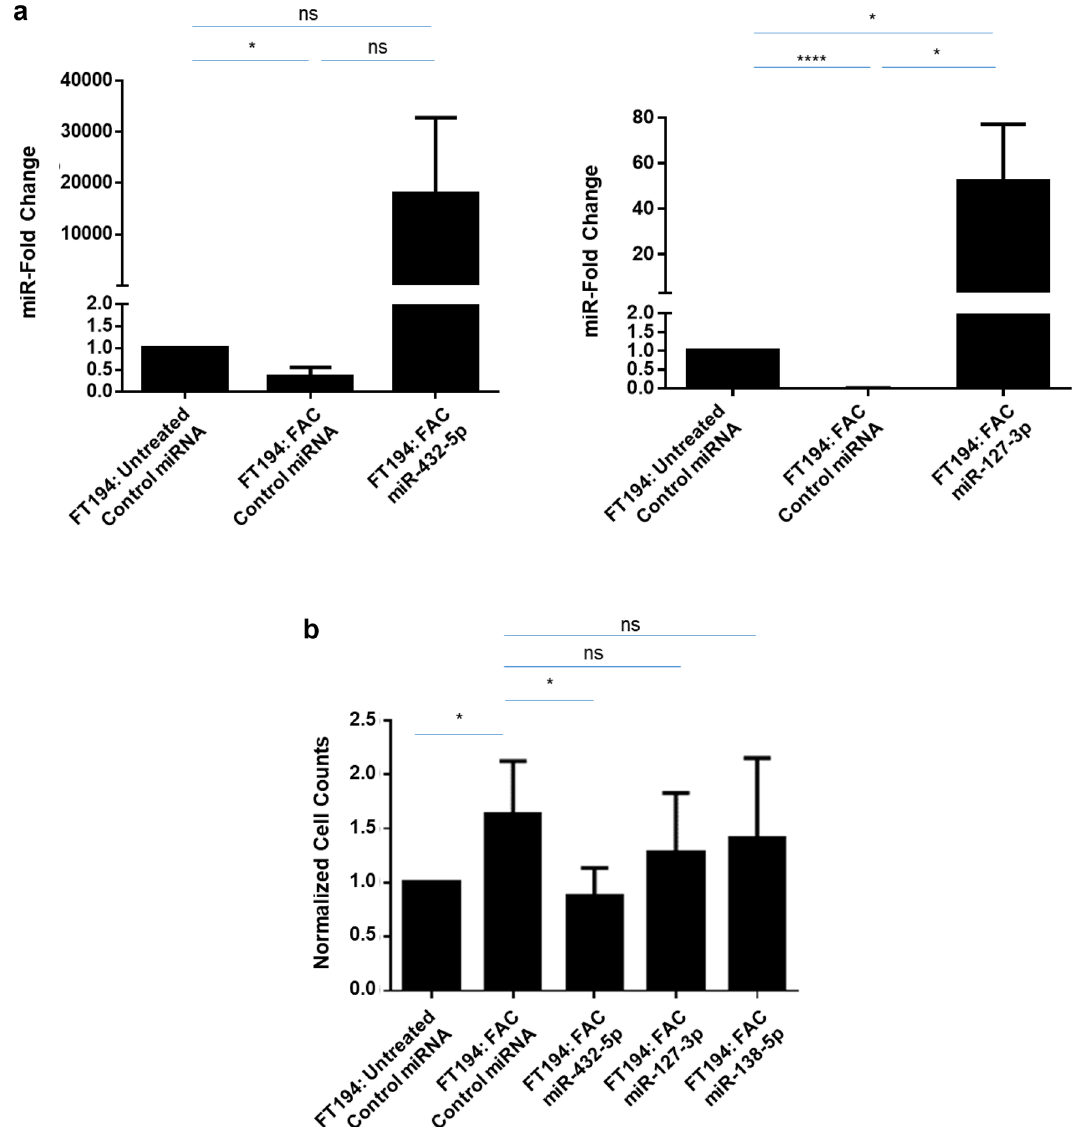
Figure 9. Overexpression of miR-432-5p, miR-127-3p and miR-138-5p in FAC-treated FT194 cells alter the cell counts and Pax8 expression level. ( a ) Real-time PCR of miR-432-5p and miR-127-3p was performed after isolating total miRNAs from the respective mimic-transfected 250 nM FAC-treated cells relative to the Untreated cells at days 123, 131, and 137 with FAC ( p = 35, 37, and 38). RNU6B was used as a reference control and the data represents a composite of three independent experiments. ( b ) Representation of cell counts obtained from overexpression of miR-432-5p, miR-127-3p, and miR-138-5p compared to control miRNA transfected Untreated and 250 nM FAC-treated FT194 cells. The data presented is the composite of five independent changes including increased cell numbers and migratory potential 10 . The work reported herein extends these findings to uncover miRNA and protein level changes under these chronic iron exposure conditions in FTSECs. Further, it is well recognized that aberrant expression of miRNAs is a characteristic of ovarian tumors with potential to serve as biomarkers and/or aid as potential diagnostic tools 41,111,112 ; however, the contribution of iron in altering their expression has not yet been reported in precursors to ovarian tumors. Thus, to comprehensively assess the iron-induced molecular changes in FTSECs, we performed an integrated miRNA and protein analysis approach in chronic iron-exposed and transformed FTSECs. To our knowledge, this is the first study to utilize a multi-omics approach to assess miRNA and protein level changes in FAC-exposed and transformed FTSECs. Herein, we have identified a subset of dysregulated miRNAs along with their corresponding protein targets via our integrated experimental approach following chronic iron exposure in FTSECs. Furthermore, we identi- fied that several miRNAs were epigenetically dysregulated which may therefore be potentially associated with